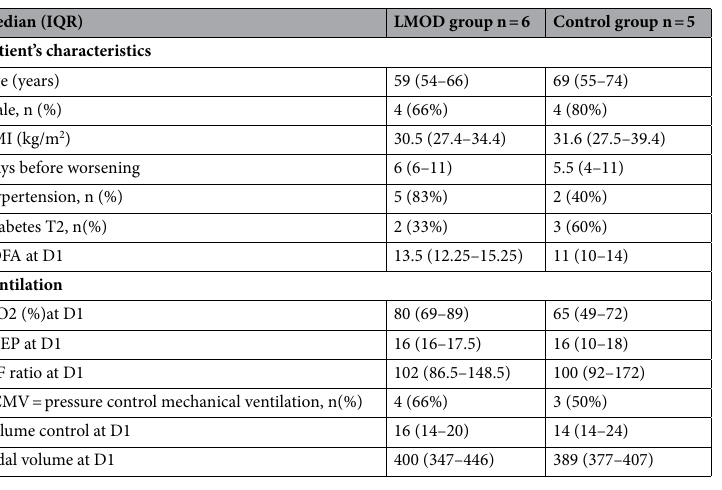
Table 1. Patient’s characteristics. BMI = Body mass index, SOFA = Sepsis-related Organ Failure Assessment, WC = white blood cells, CRP = C-reactive protein, AST = Aspartate aminotransferase. *Friedman test, p significant for p <